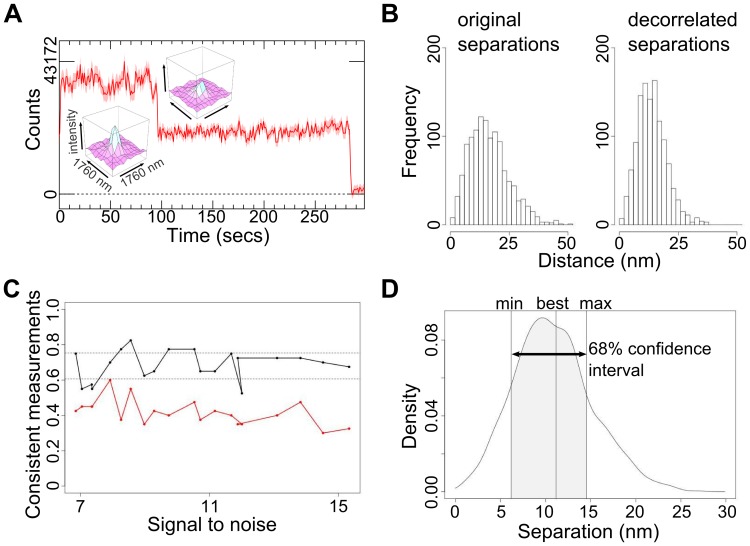
Measuring the separation between two molecules.(A) Example intensity v time course from a spot on cells showing a pair of Affibody-Atto 647N molecules photobleaching in two steps. Images were acquired every 0.28 s. The insets show the profile of the spot before and after the first bleaching event. (B) Original and decorrelated separations to illustrate the effect of anti-correlated positional error. The data of each spot is resampled and fitted 1200 times yielding 1200 sets of seven parameters that are samples of the 7-dimensional parameter distribution. In the decorrelated version the parameters have been independently randomly reordered, i.e. parameters from the same set end up in different sets. (C) Comparison of the error estimation of the Thompson, Larson and Webb [34] and sequential photobleaching NALMS analysis method [29] (red line) to our FLIP variant (black line) for synthetic data, depending on the SNR. SNR is the ratio of the measured mean intensity of a single-fluorophore trace to its standard deviation. The graph shows how often the real distance lies within the 68% confidence interval of the measurement. For [34], the confidence interval was taken as separation estimate ± standard deviation; for FLIP the confidence interval was taken as the shortest interval that contains 68% of the separation results from the bootstrap sampling (1,200 samples per measurement). (D) A probability density plot of the separations from the bootstrap samples of an individual measurement, showing the best fit value and the confidence interval.